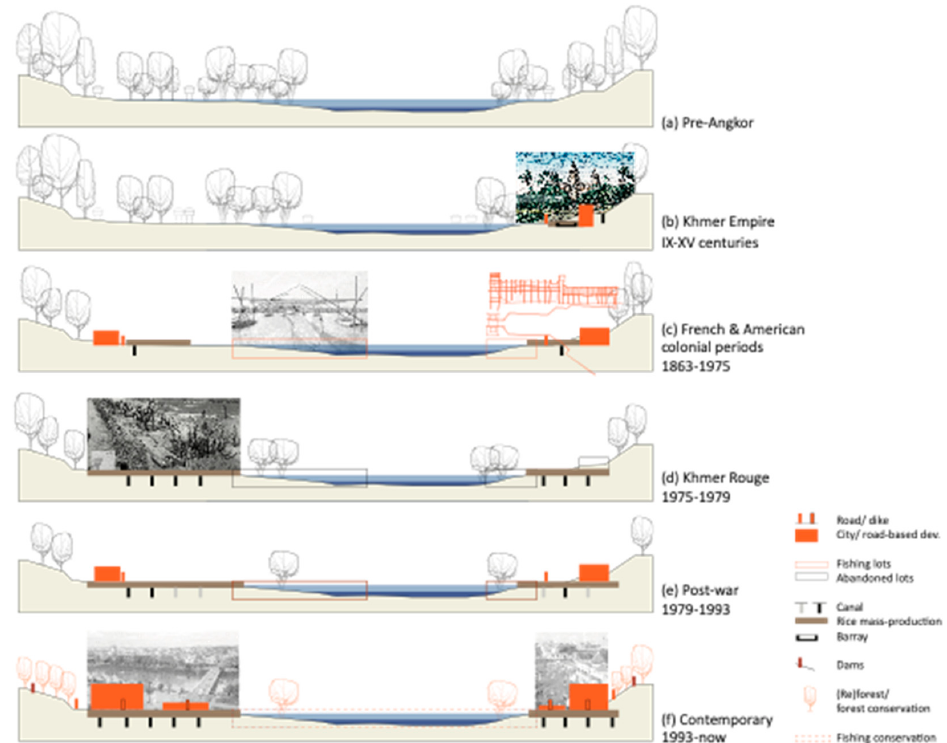
Figure 11. Evolution of the Tonle Sap’s development. A great deal of urban and infrastructure development propelled deforestation that dramatically altered the lake’s hydro − ecology. Over time, hard engineering, and simplification by the State of the area’s nuances continued a legacy of exploitation (Linh Vu, April 2022).